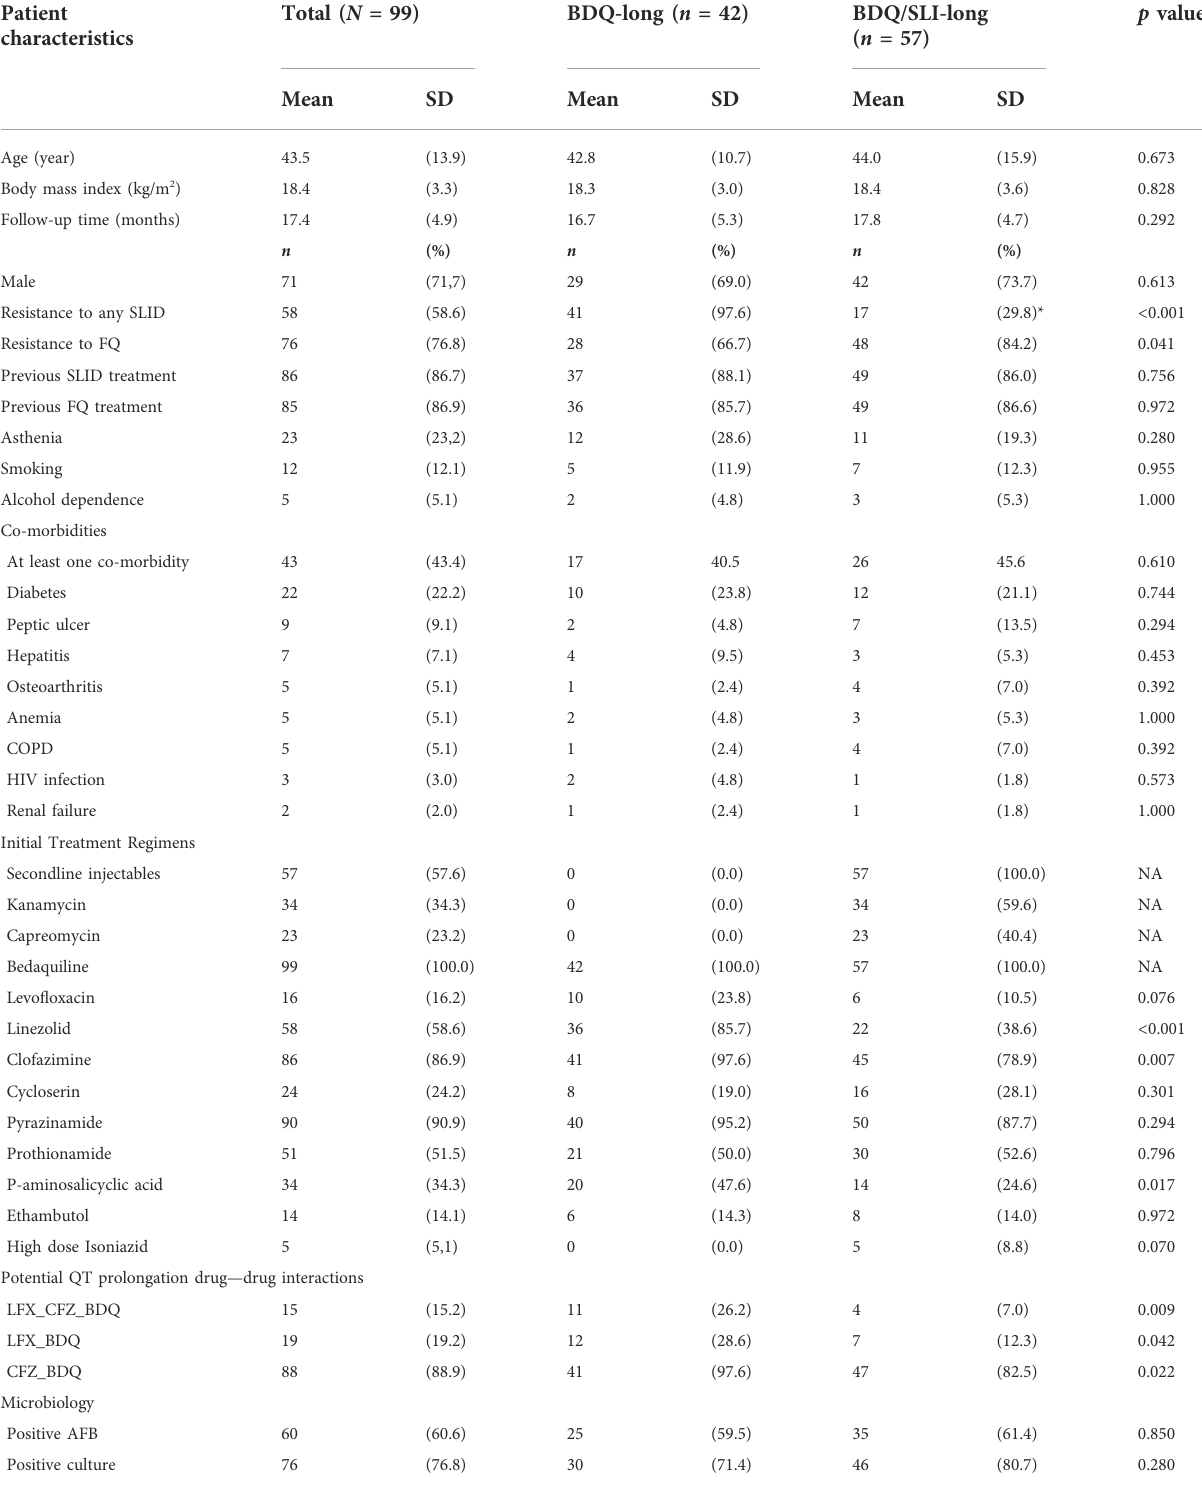
TABLE 1 Patient characteristics by